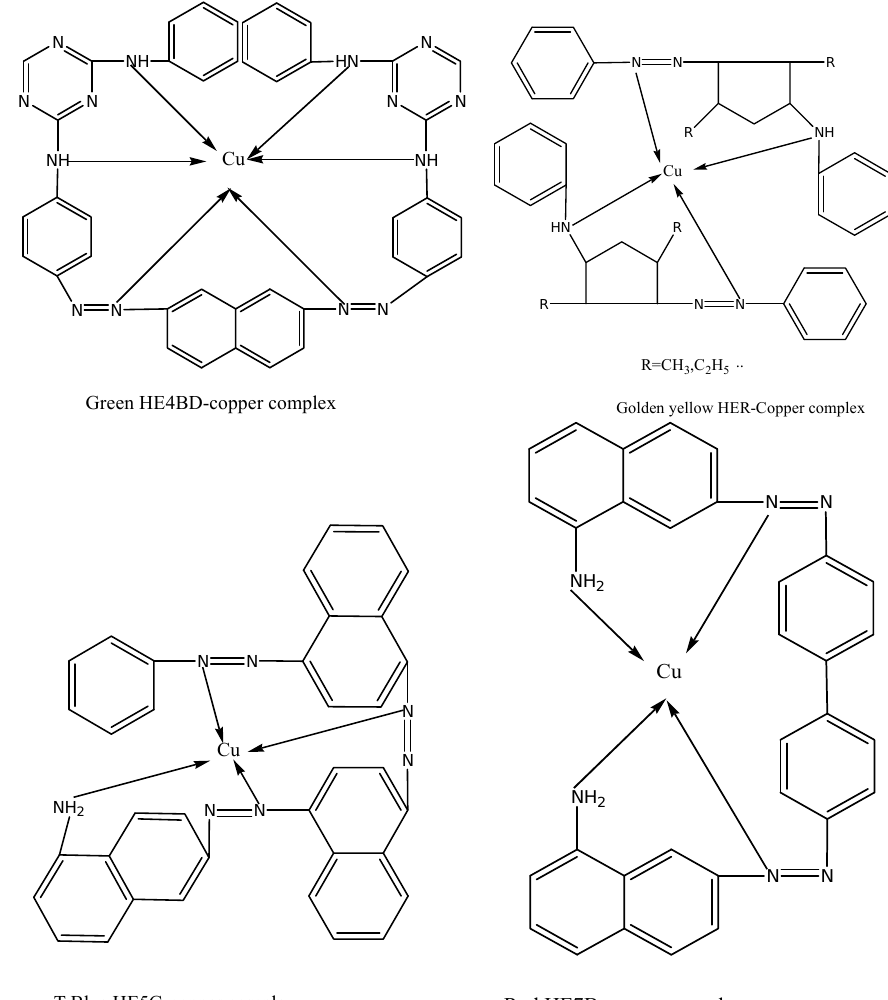
Figure 2. Structure of copper-azo dyes